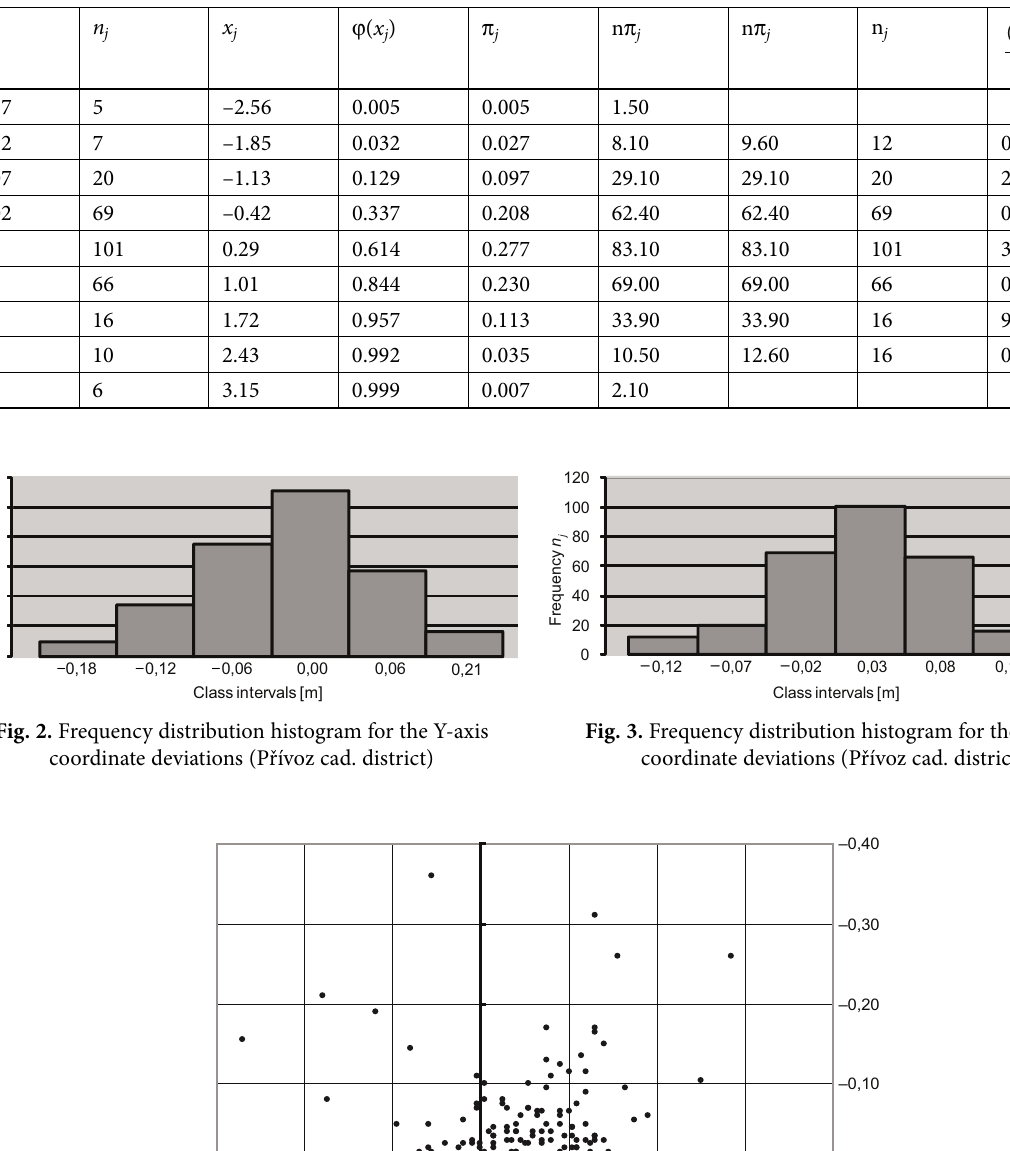
Table 6. Calculation schema of test statistic χ y